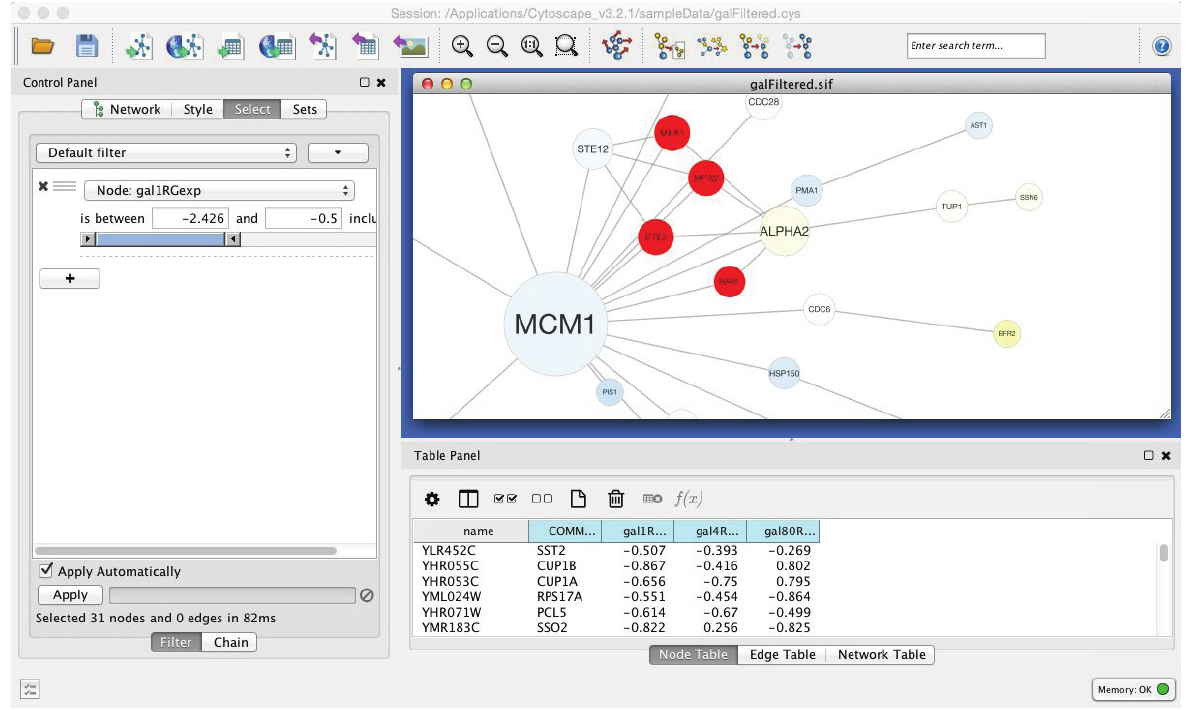
Figure 1. Screenshot of Cytoscape’s Select panel with underexpressed genes in the gal1RGexp condition being selected. Nodes that match the gal1RGexp condition are highlighted in